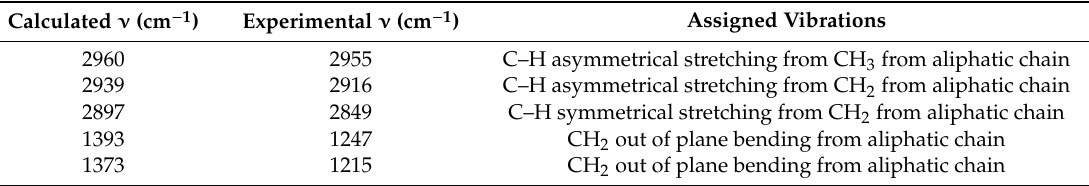
Table 1. Experimental and calculated vibration frequencies for